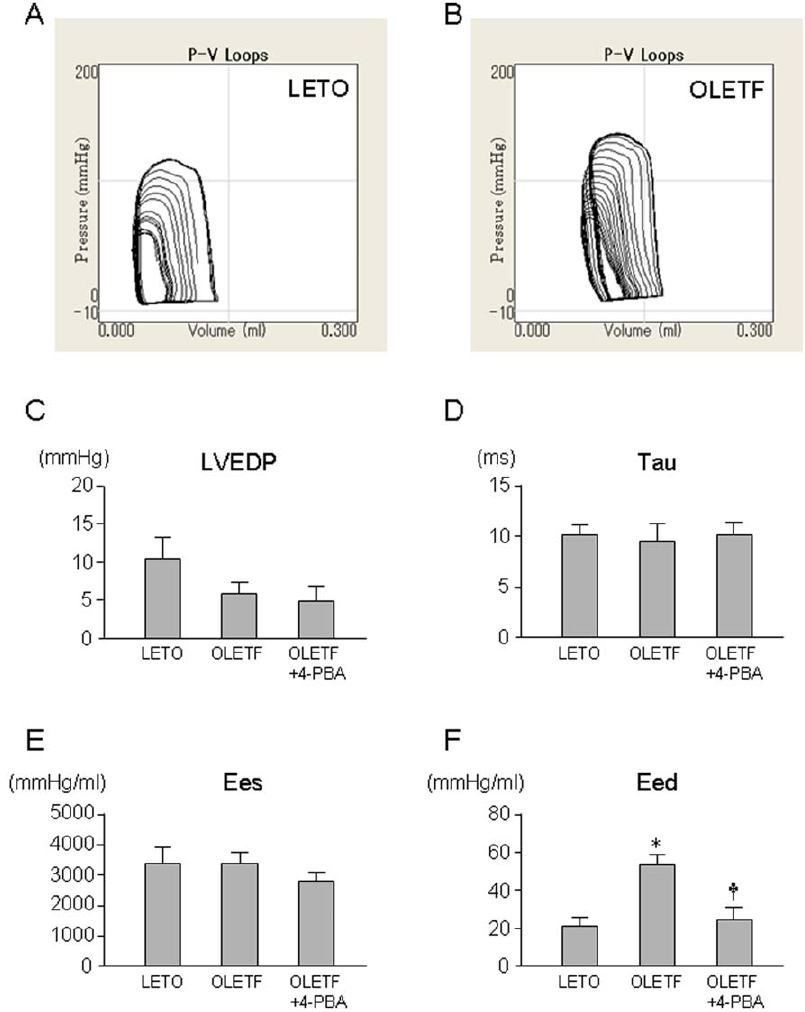
Figure 1. LV functions determined by pressure-volume relationships. Representative examples of pressure-volume relationships in LETO (A) and OLETF (B) and summary data of LVEDP (C), tau (D), LV Ees (E), and LV Eed (F) are shown. *p , 0.05 vs. LETO, { p , 0.05 vs. OLETF. n=5 , 6. LVEDP= left ventricular end-diastolic pressure; tau= time constant of left ventricular pressure decay; Ees= end-systolic elastance; Eed= end-diastolic elastance; 4-PBA=4-phenylbutyric acid.